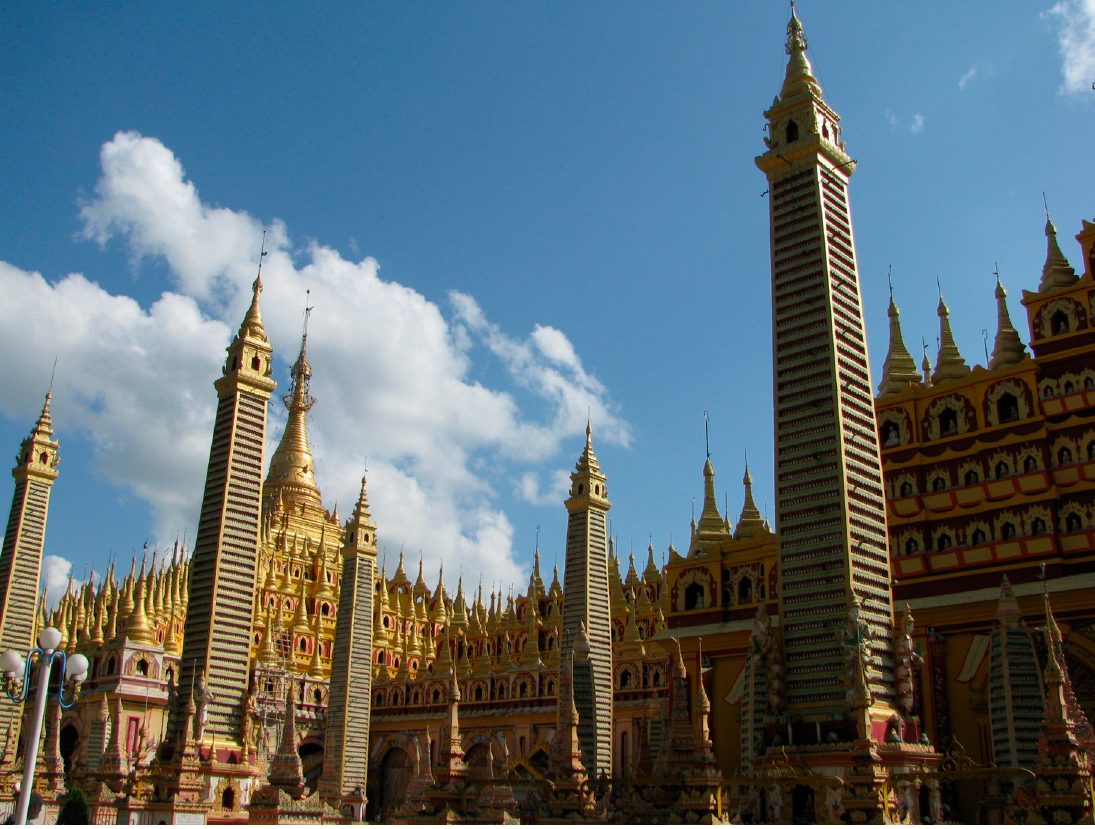
Figure 7. Thambuddhe Pagoda in Monywa, Myanmar. Photo courtesy Andrew Dicks.